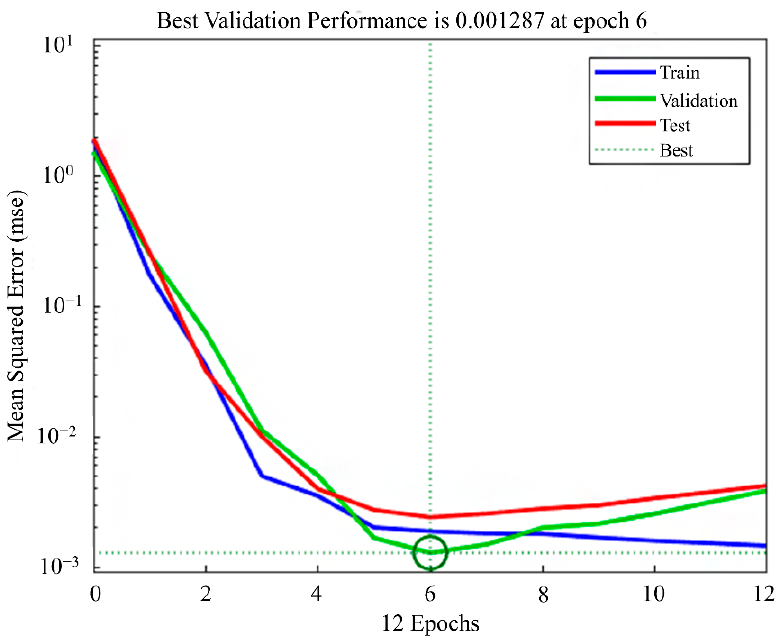
Figure 5. Variation curve of network error.